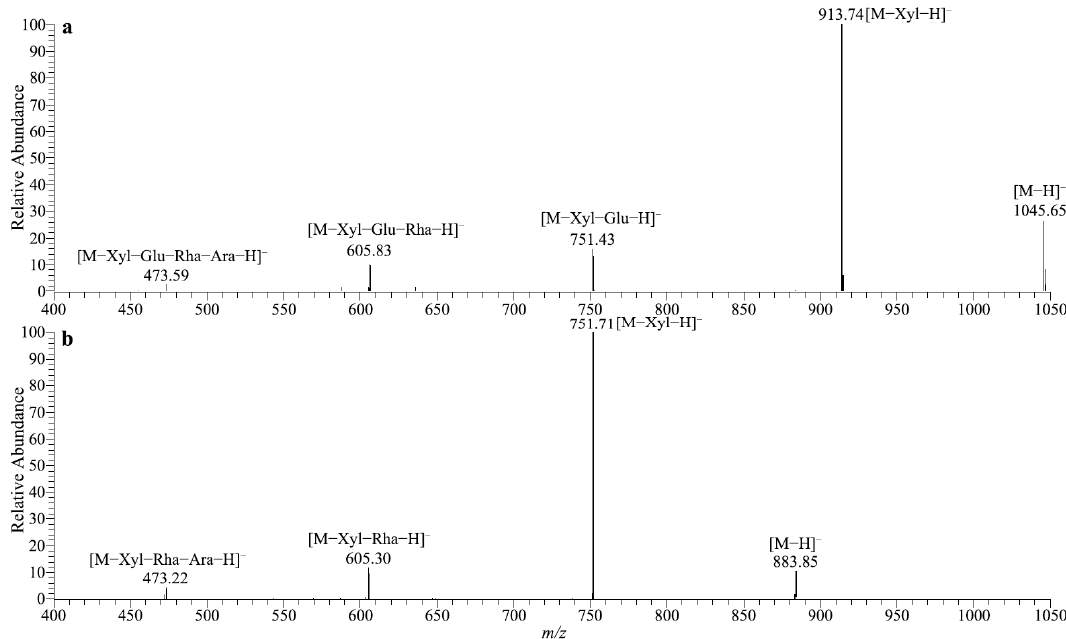
Figure 3. MS/MS spectra of gypenoside XLIX ( a ) and its transformed product ( b ).